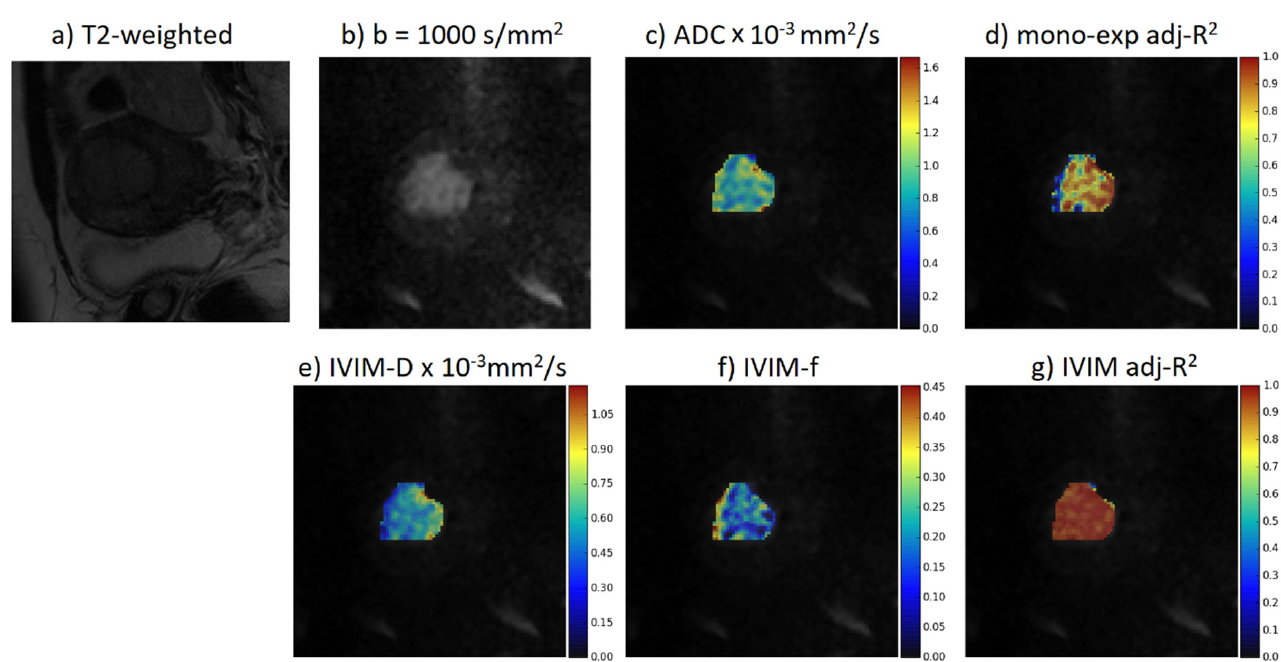
Figure 1. From top left to bottom right: A T2-weighted MRI, DWI acquired at b = 1000 s/mm², and parametric maps for the ADC, adj-R 2 when the diffusion signals were fitted by the mono-exponential model, D, f, and adj-R 2 when the diffusion signals were fitted by the bi-exponential model. ADC: apparent diffusion coefficient; adj-R 2 : adjusted R-squared; D: diffusion coefficient; f: micro-perfusion fraction.